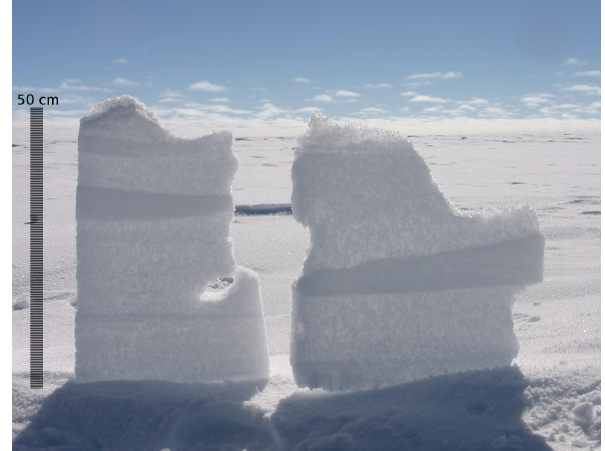
Figure 15. Photograph of a thin vertical section extracted from 5m depth at Dome C in January 2010 showing the persistence of het- erogeneity at